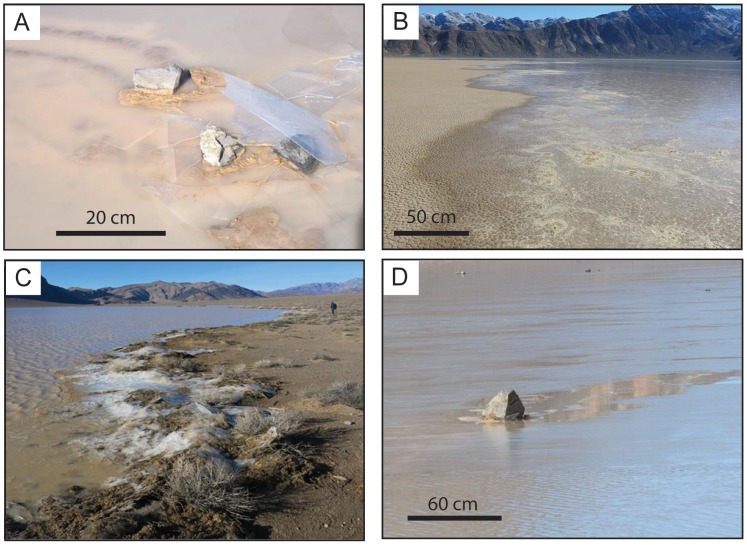
Racetrack Playa phenomena.Parts show: (a) thin windowpane ice over-riding a recently moved rock (January 9, 2014), (b) water creeping onto the low gradient northern shore of the pond during the December 20, 2013 rock movement (∼11:15 am), (c) ice windrows on the eastern shore of Racetrack Playa near the weather station (∼1 pm, December 20, 2013); ice panels are ∼2–3 mm thick and mixed with mud and rocks scoured from the pond bottom, (d) rock carving a wake through ice that is moving left to right; open rippled water in the foreground (January 9, 2014). Images have been cropped but not otherwise edited.